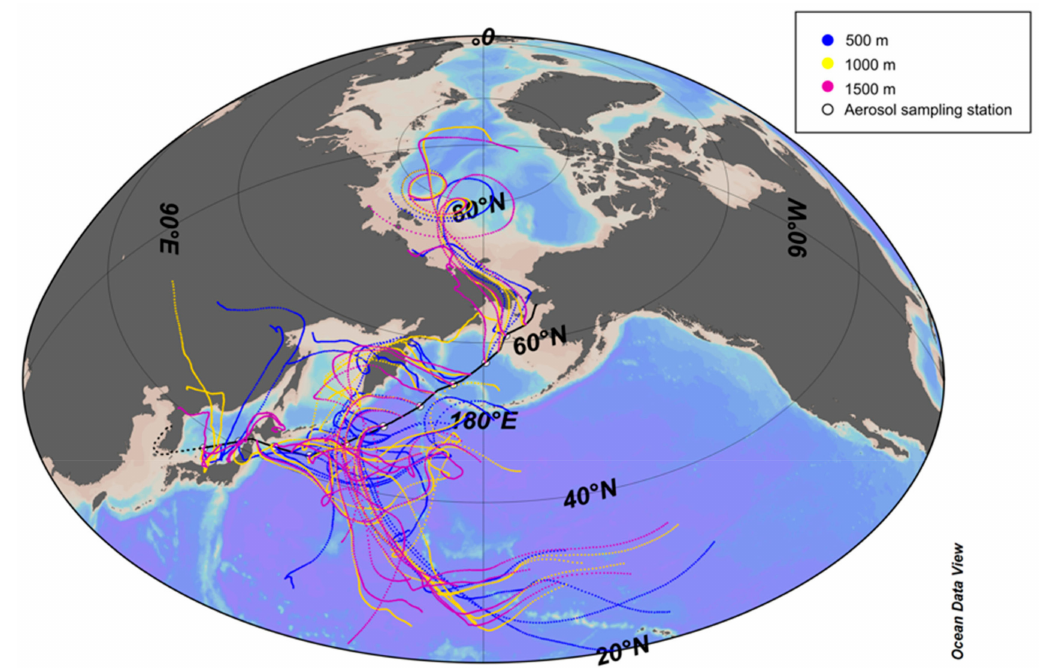
Figure 3. The 168 h (7 days) air mass backward trajectories for starting altitude 500 (blue dots), 1000 (yellow dots), and 1500 m (purple dots) above ground level (a.g.l.) during the collection of aerosol samples calculated from the Global Data Assimilation System (GDAS) database of the National Ocean and Atmospheric Administration (NOAA) and simulated by using the Hybrid Single-Particle Lagrangian Integrated Trajectory (HY-SPLIT) model [46]. White circles and black line indicate aerosol sampling locations and cruise track,